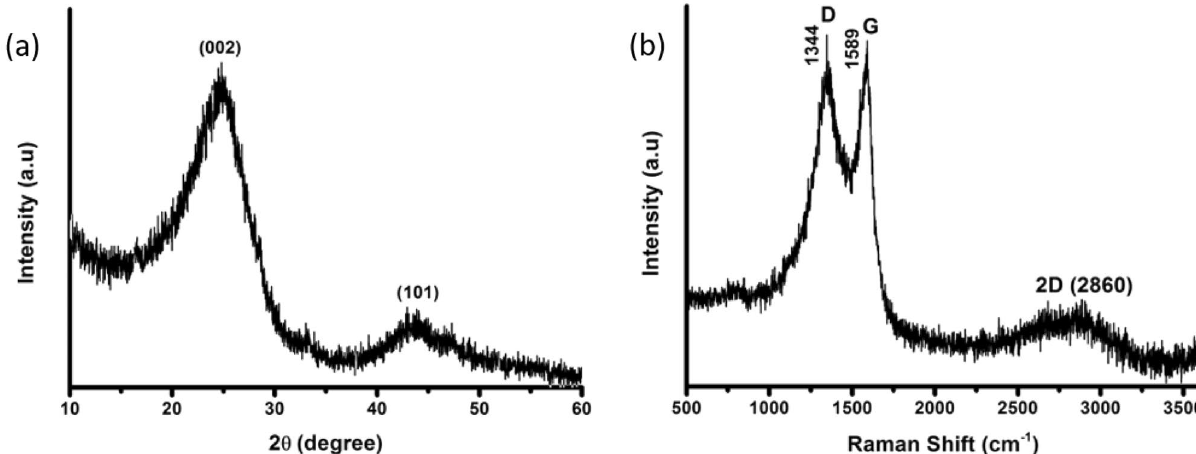
Figure 2. ( a ) XRD pattern of as-synthesized CNP, ( b ) respective Raman